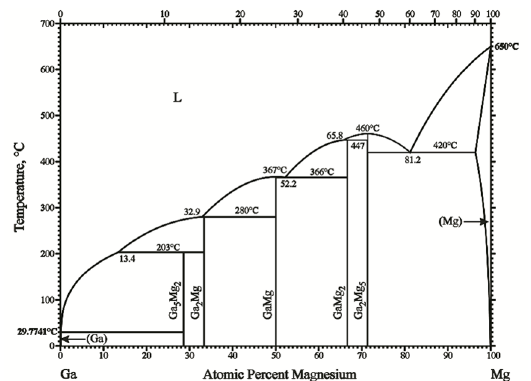
Figure 1. The Ga-Mg equilibrium phase